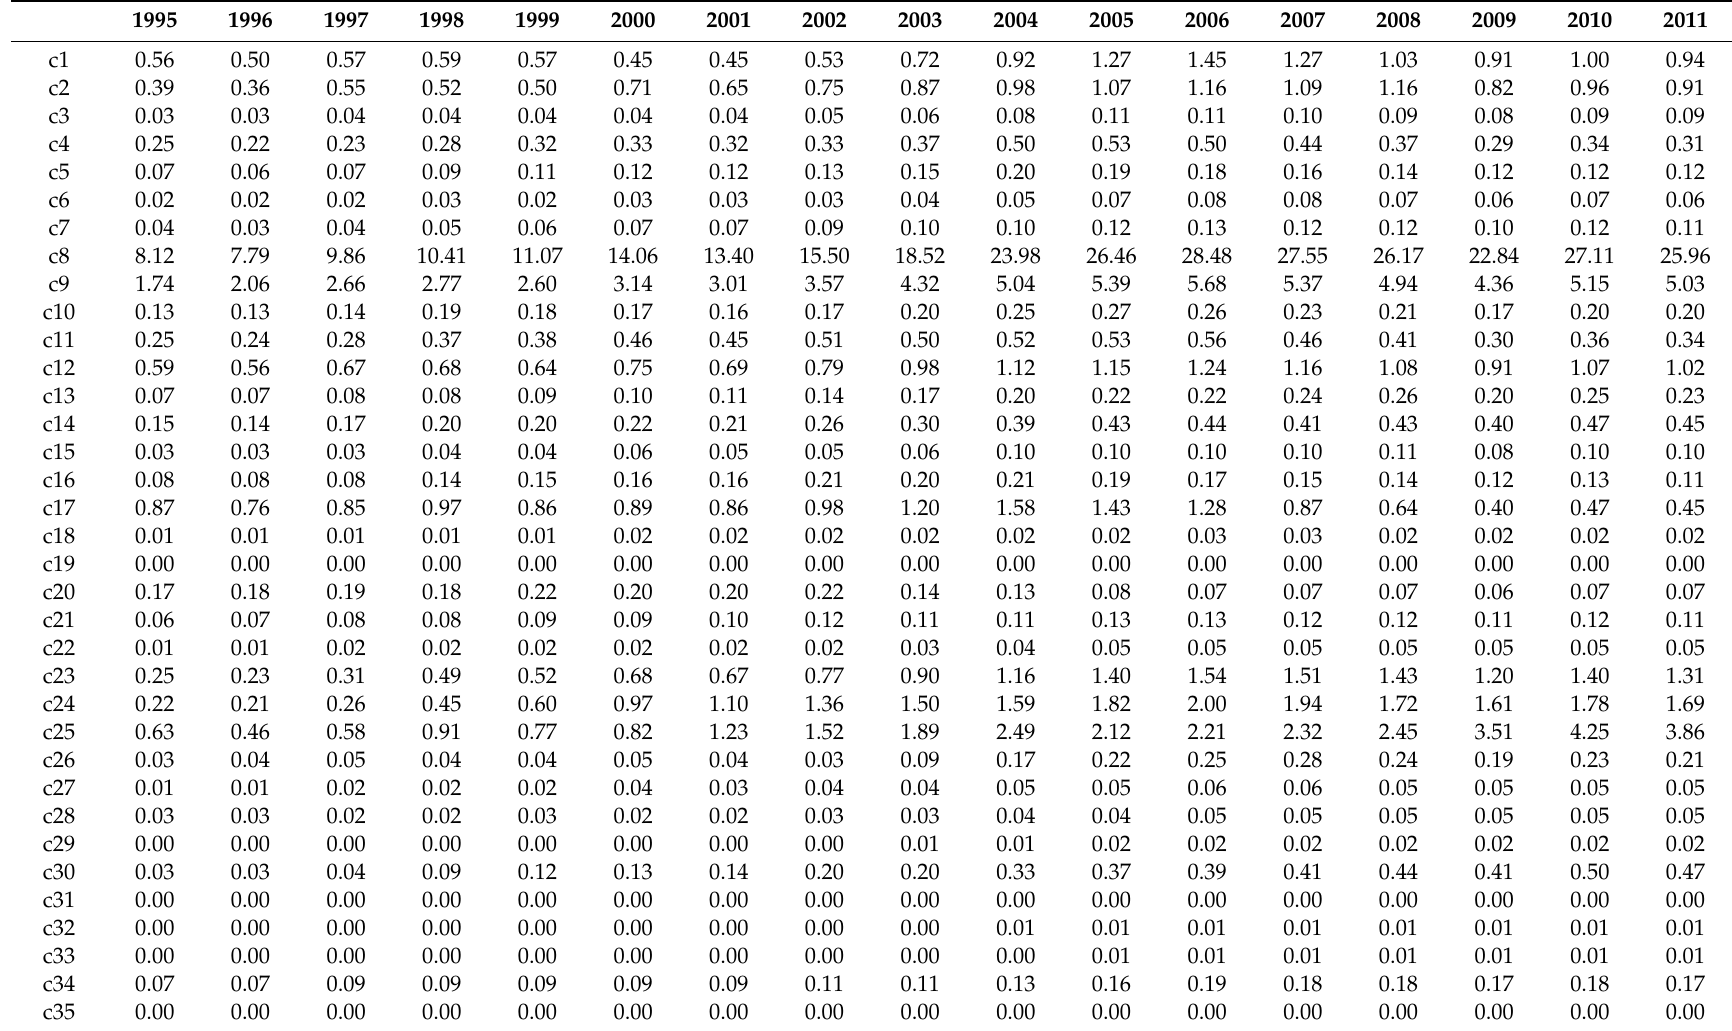
Table A6. The oil consumption embodied in China’s inter-industry exports to the US